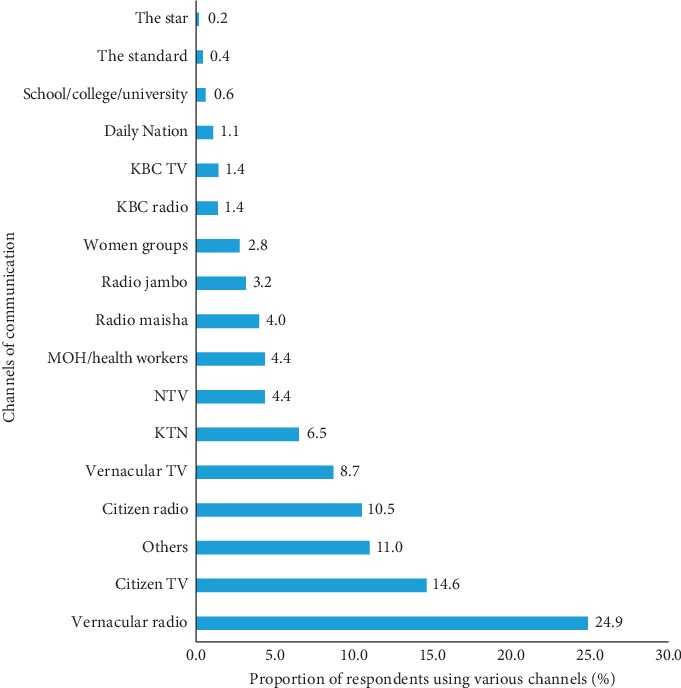
Respondents' preferred channels for communicating food fortification.